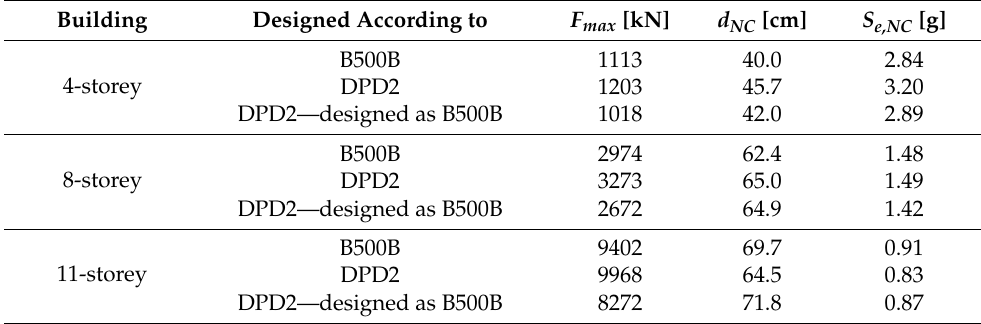
Table 5. Maximum base shear ( F max ), near-collapse roof displacement ( d NC ) and median spectral accelerations at first vibration period, causing a near-collapse limit state ( S e,NC